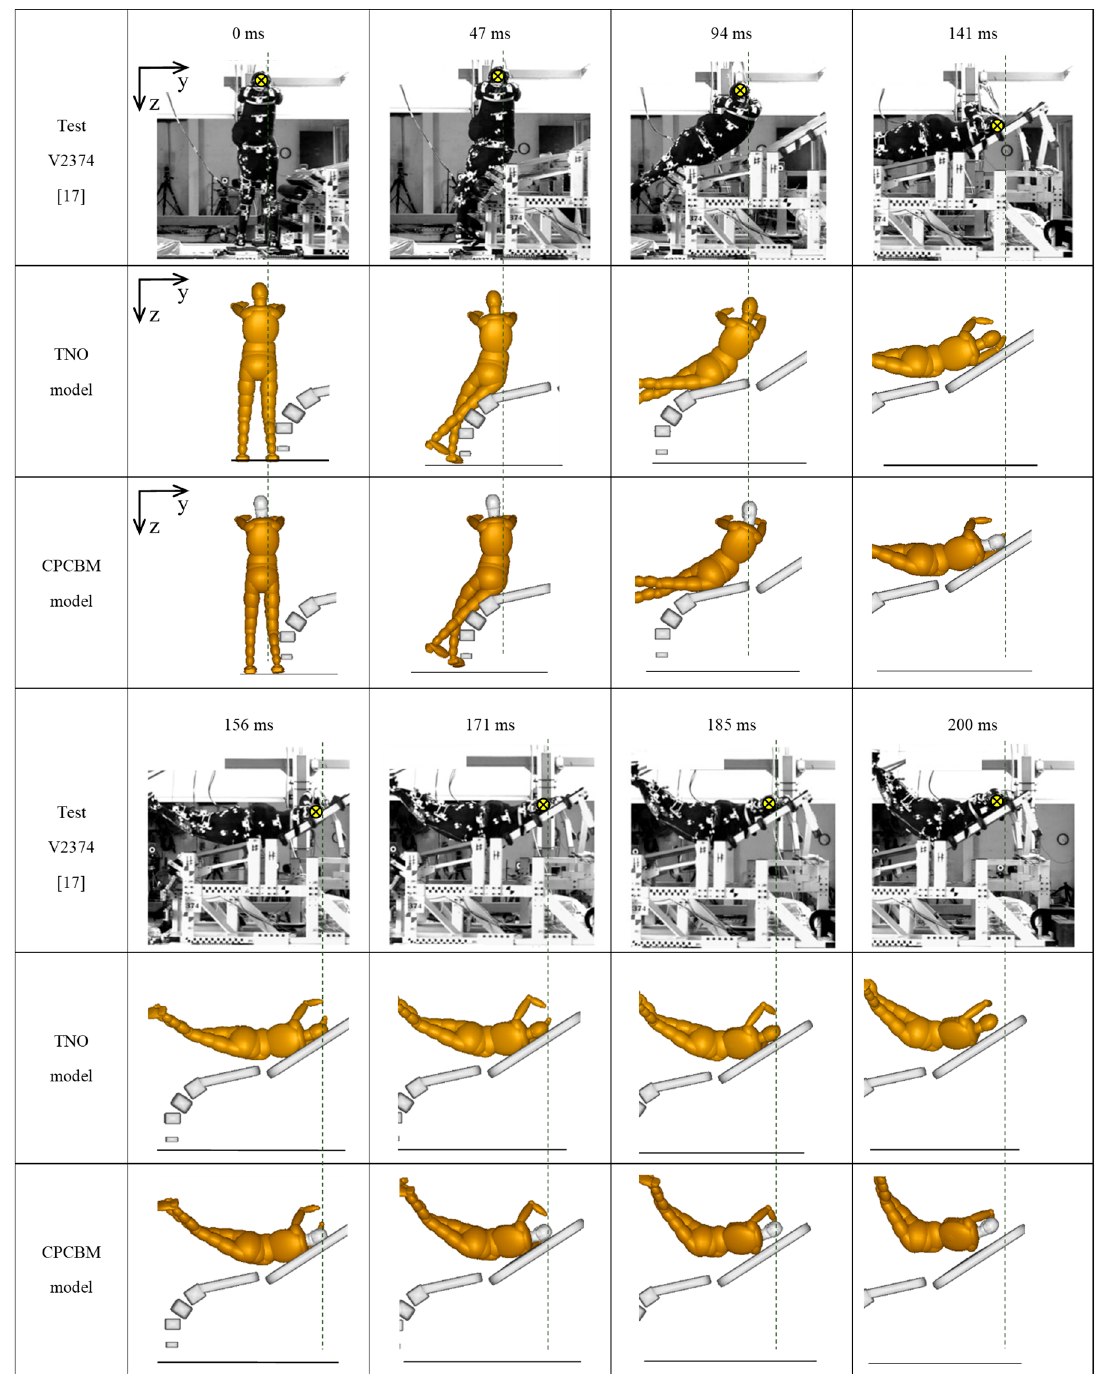
Figure A5. Motion responses of PMHS, the TNO model (gold color), and CPCBM (mixed color) for test V2374 (posterior view) [17].